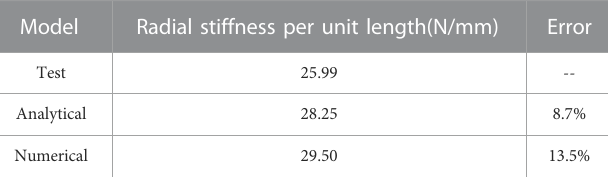
TABLE 3 Radial stiffness of the fi bre reinforced fl exible pipe calculated using different methods.